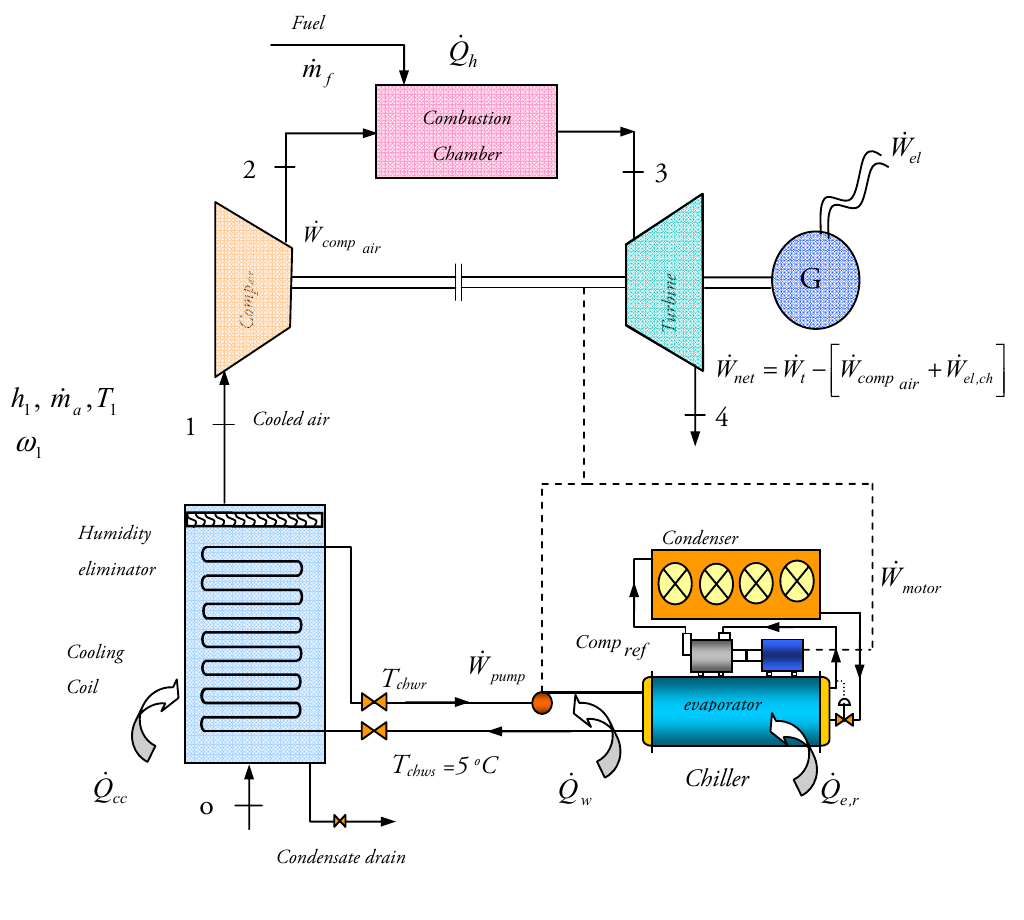
Fig. 1.a. Simple open type gas turbine with a chilled air-cooling